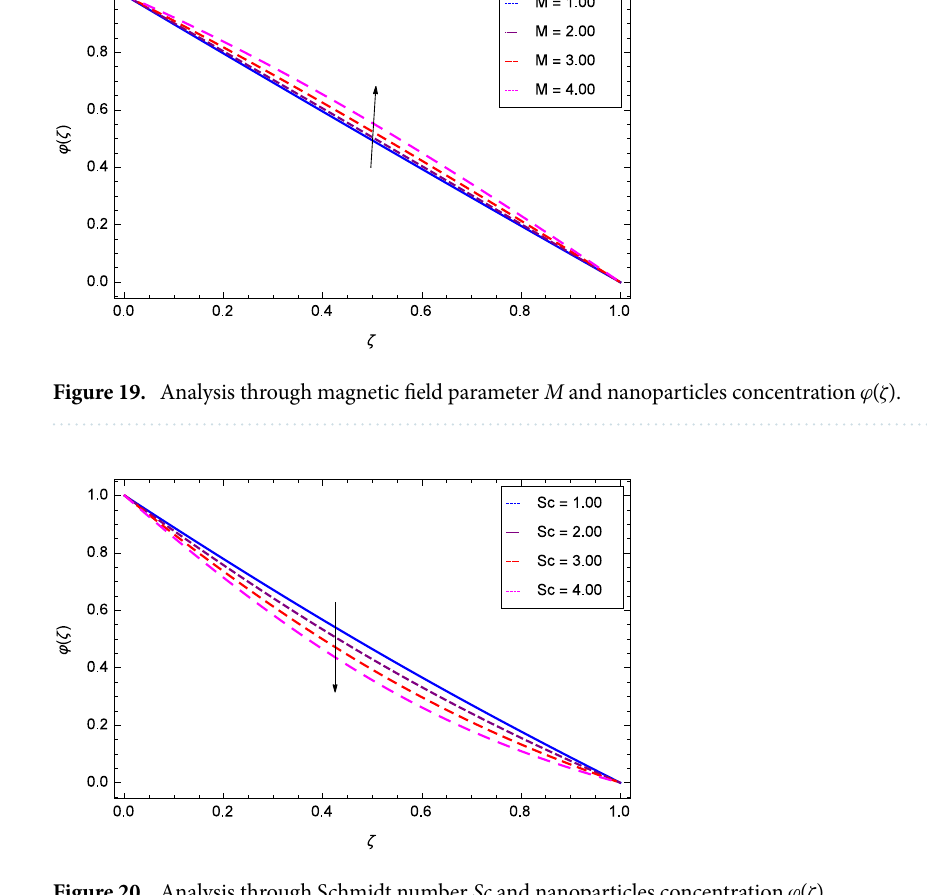
Figure 20. Analysis through Schmidt number Sc and nanoparticles concentration ϕ ( ζ